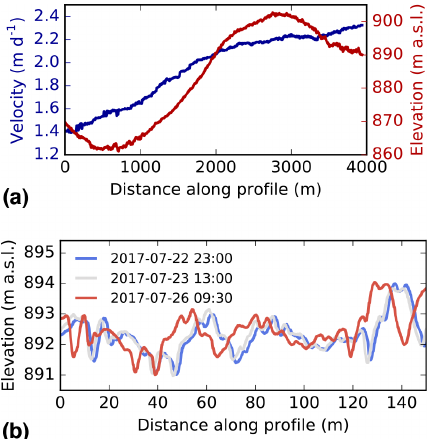
Figure 8. (a) Transect of A–A (cid:48) in Fig. 7a, displaying velocity (blue) and elevation (red). (b) Transect of B–B (cid:48) in Fig. 7a, displaying ele- vation profiles of a crevasse field through the study period.